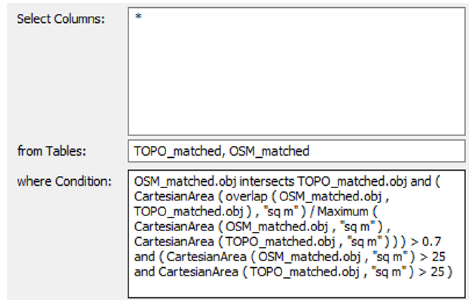
Fig. 4. SQL query for the data matching